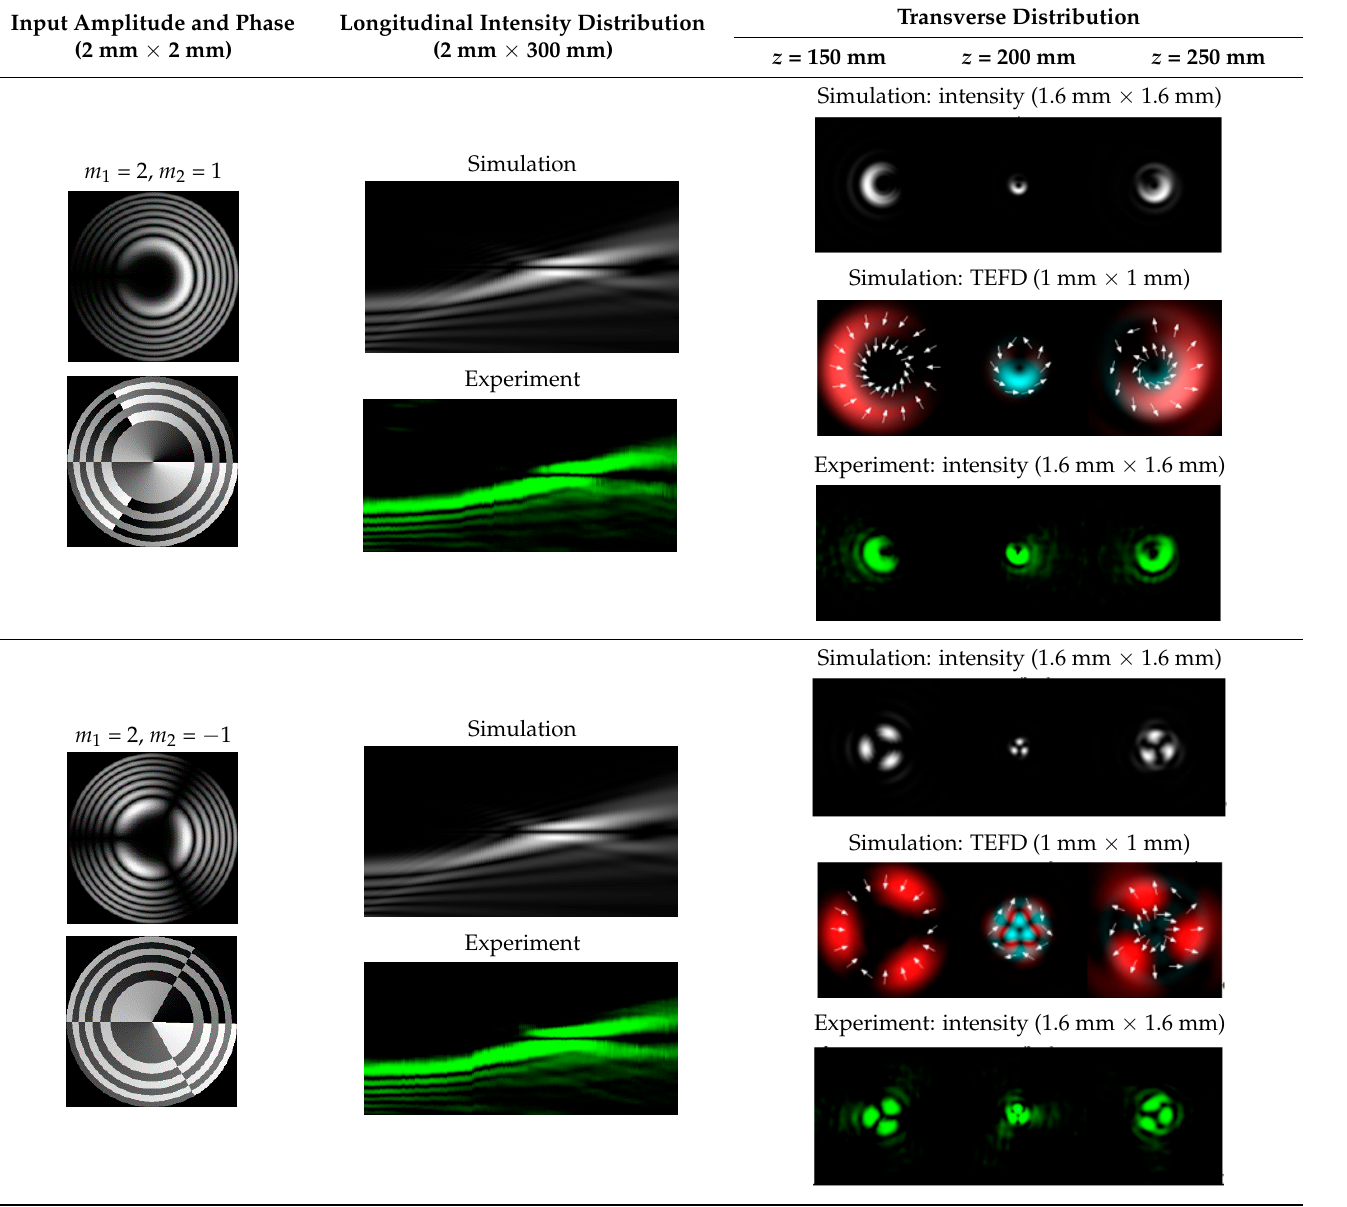
Table 1. Results of simulations and experiments for the field defined by Equation (14) with different orders of vortex terms m 1 , m 2 .